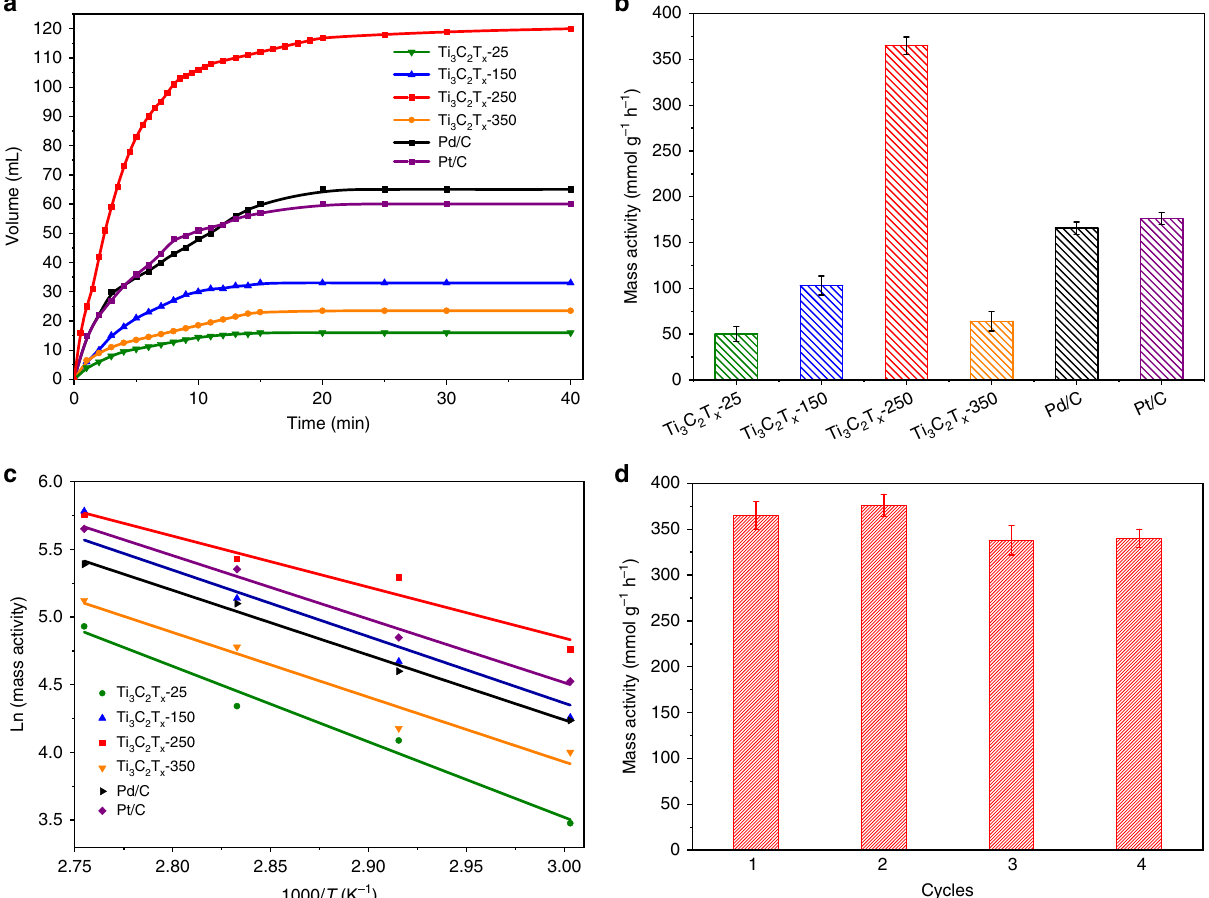
Fig. 3 Catalytic performance of different catalysts in the dehydrogenation of HCOOH. a Plots of the volume of gas formed from HCOOH decomposition over different catalysts versus time at 80 °C. b Comparison of mass activities for different catalysts. c Arrhenius plot for the dehydrogenation of HCOOH over different catalysts. d Catalytic performance of Ti 3 C 2 T x -250 after successive rounds of reaction. The error bar was drawn based on the calculated standard error of three parallel